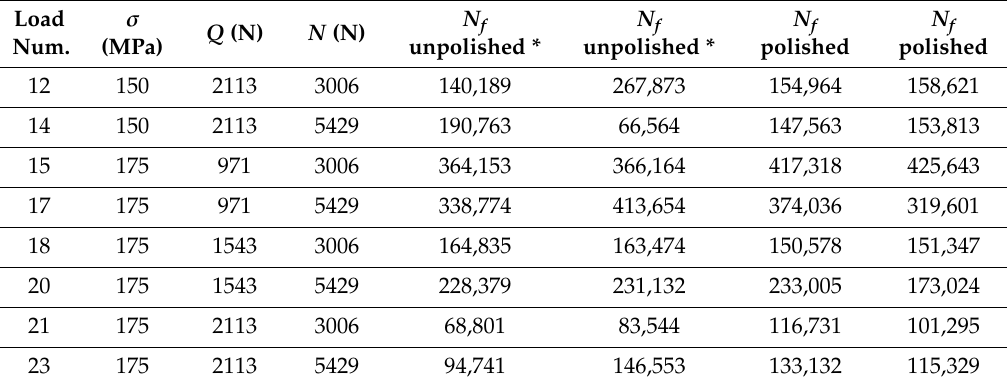
Table 5. Lives in the tests with shot peening, polished and